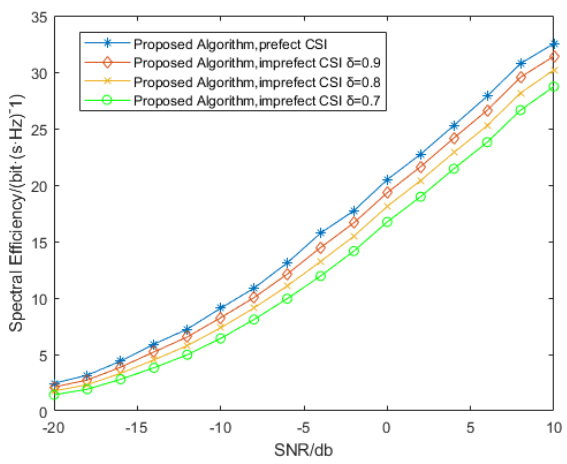
Figure 4. Impact of imperfect CSI on the proposed algorithm ( 𝑁 𝑡 × 𝑁 𝑟 = 128 × 16 , N RF =8, N s = 8).